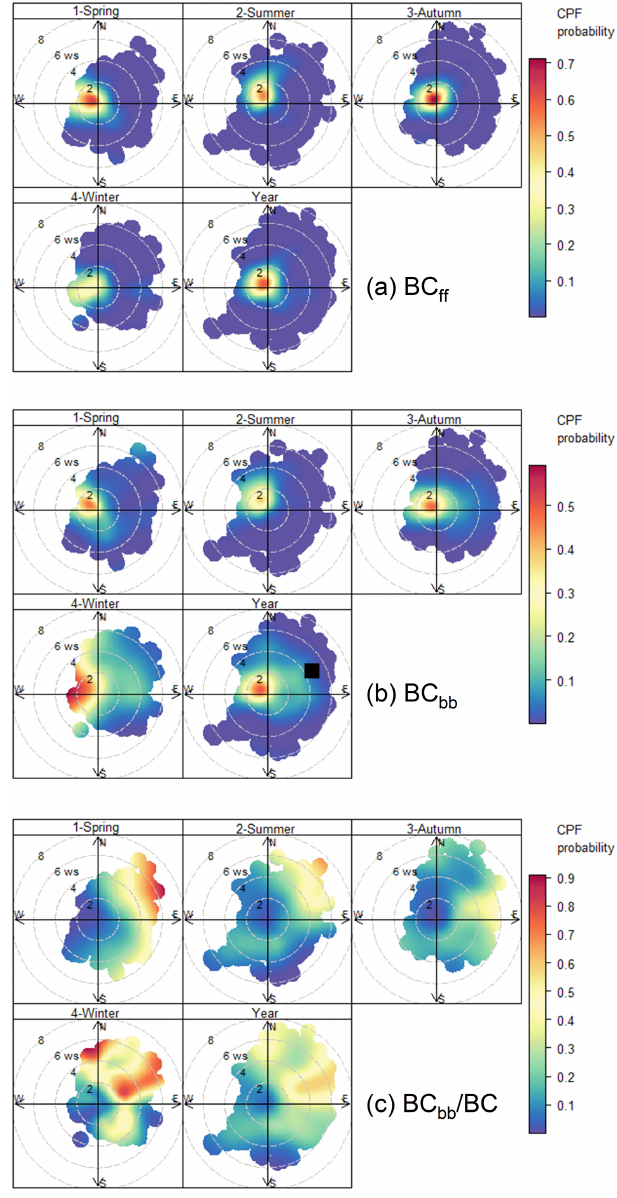
Figure 6. CPF plots for (a) BC ff , (b) BC bb and (c) BC bb contribu- tions in Xiamen in 2014. ws represents wind speed (ms − 1